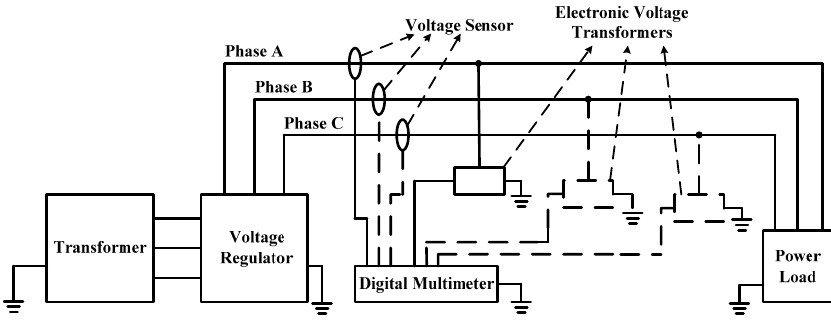
Figure 23. Schematic diagram for the structure of accuracy test platform.